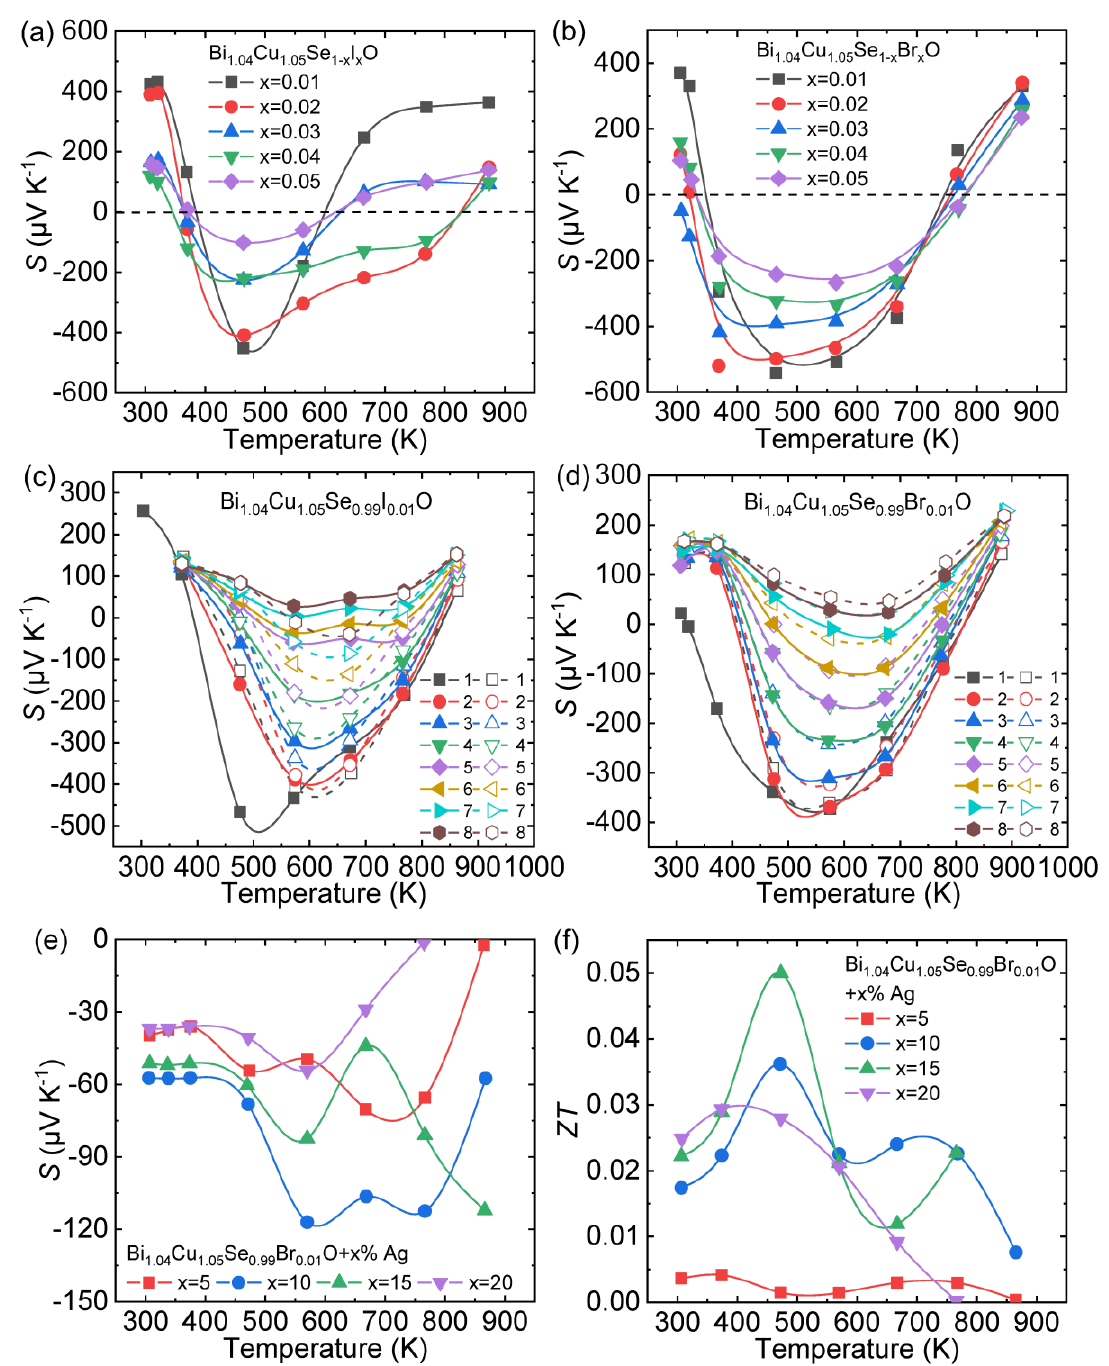
Figure 4. The temperature dependence of Seebeck coefficient for ( a ) Bi 1 . 04 Cu 1 . 05 Se 1+x I x O ( x = 0.01–0.05) and ( b ) Bi 1 . 04 Cu 1 . 05 Se 1+x Br x O ( x = 0.01–0.05). The temperature-dependent Seebeck coefficients obtained through heating-cooling cycle measurements: 8 cycles for ( c ) Bi 1 . 04 Cu 1 . 05 Se 0 . 99 I 0 . 01 O and ( d ) Bi 1 . 04 Cu 1 . 05 Se 0 . 99 Br 0 . 01 O, respectively. The solid symbols and lines express the heating process, while the dashed symbols and lines express cooling process. The temperature dependence of ( e ) Seebeck coefficients and ( f ) ZT value of Bi 1 . 04 Cu 1 . 05 Se 1+x Br x O + x % Ag ( x = 5–20). Data shown in ( a , b , e , f ) were adopted from Reference [61]. Copyright 2017, Elsevier Inc. Data shown in ( c – d ) were adopted from Reference[66]. Copyright 2019, Elsevier Ltd and Techna Group S.r.l.